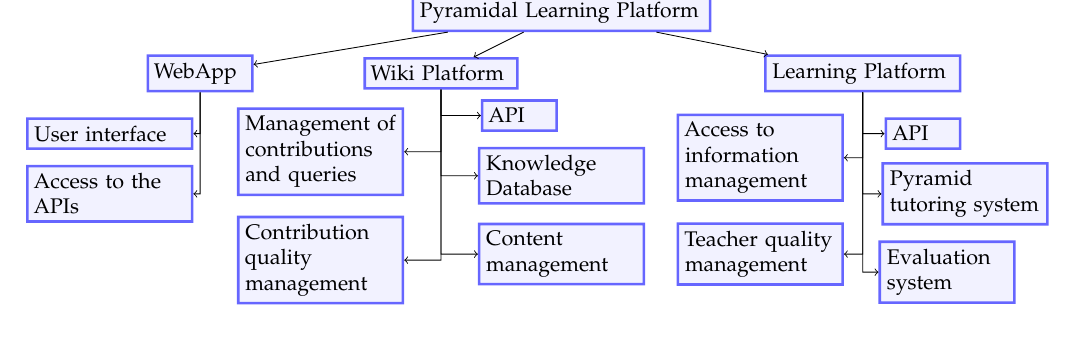
Figure 1. Structure diagram.